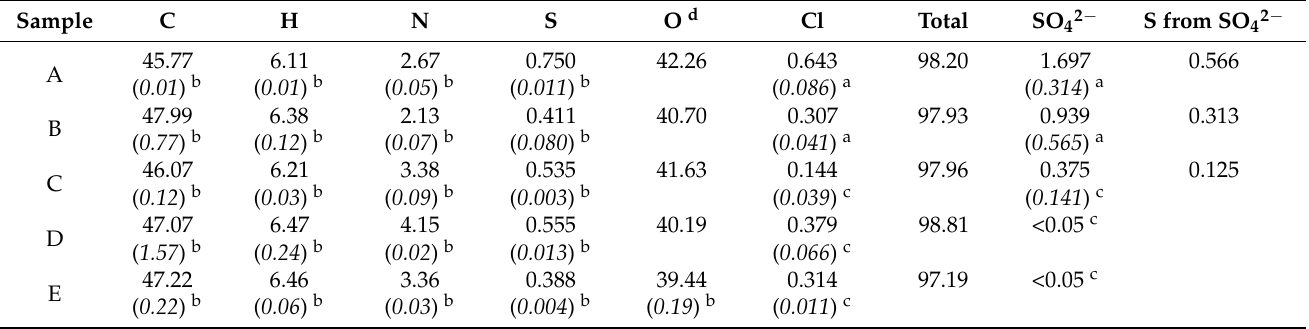
Table 2. Results (% w / w ) of the organic elemental microanalysis of dried Palicourea luxurians leaves, from which compound 1 was isolated (A), another plant of the same (B) and three plants of the related species P. berteroana (C–E) from other regions of Costa Rica. Plant A shows elevated content of S and SO 42 − compared to